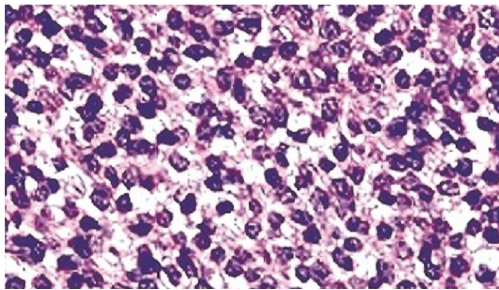
Figure 2: Microscopic analysis showing sheets of small round blue cells.